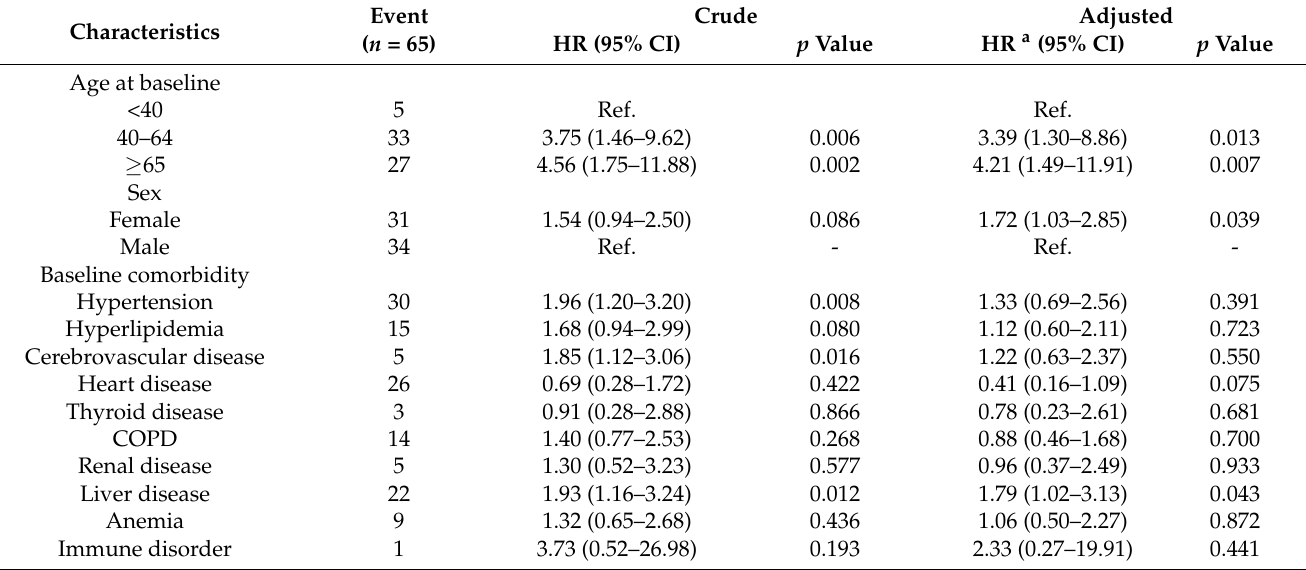
Table 2. Risk of type 2 diabetes following colectomy in patients without colorectal cancer during 14-year follow-up.